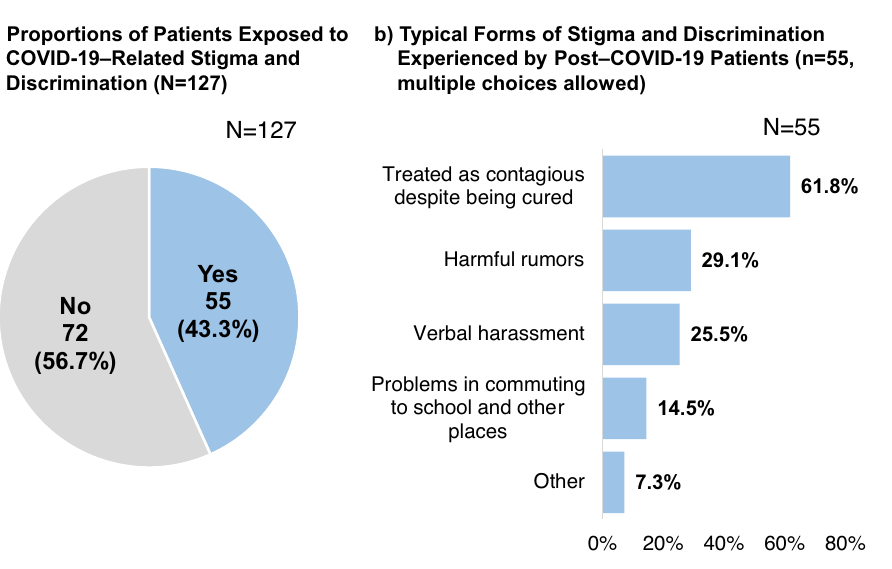
Figure 3. COVID-19–related experiences of stigma and discrimination. The pie chart on the left ( a ) shows the proportion of patients exposed to COVID-19–related stigma and discrimination (n = 127). The bar chart on the right ( b ) presents the typical forms of stigma and discrimination experienced by post–COVID-19 patients (n =